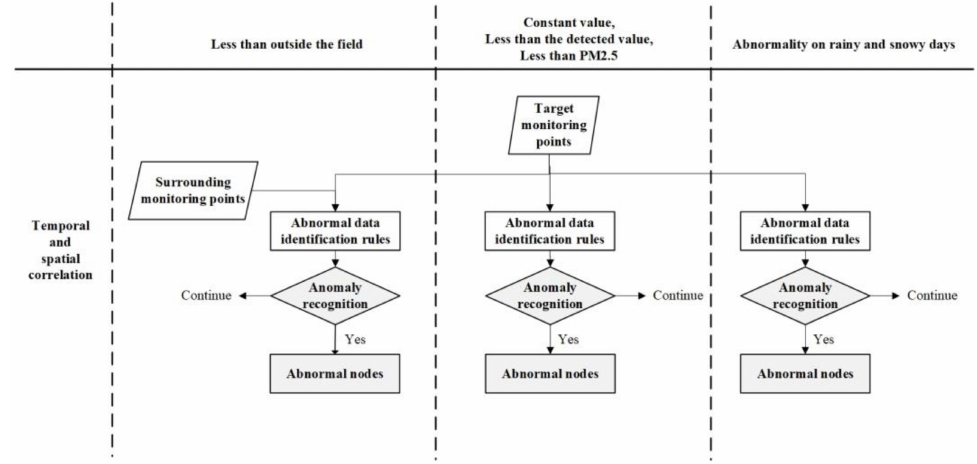
Figure 7. Identification process of abnormal